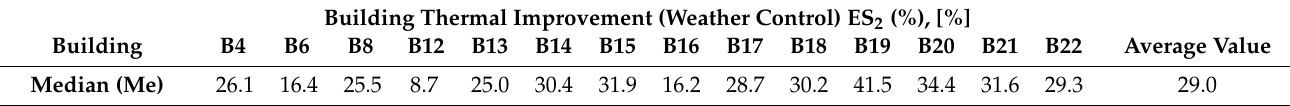
Table 10. The study included a group of buildings designated as: B4, B6, B8 and B12–B22. Table 10. Energy savings after thermal improvement only (weather control) ES 2 (%), %.